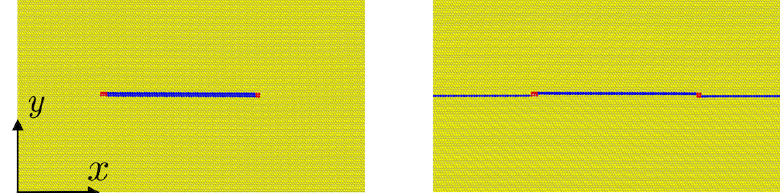
Figure 2. Dislocation configuration in a periodic simulation cell for determination of the velocity of bulk ( left ) and twin boundary ( right ) straight partial dislocations. Left: partial edge dislocation dipole in the bulk. Right: partial edge dislocation dipole on the twin boundary. In all cases, the dislocation line is parallel to the z direction i z , the glide plane unit normal to the y direction i y , and the glide direction to the x direction i x . The cell size is ( L x , L y , L z ) = ( 60